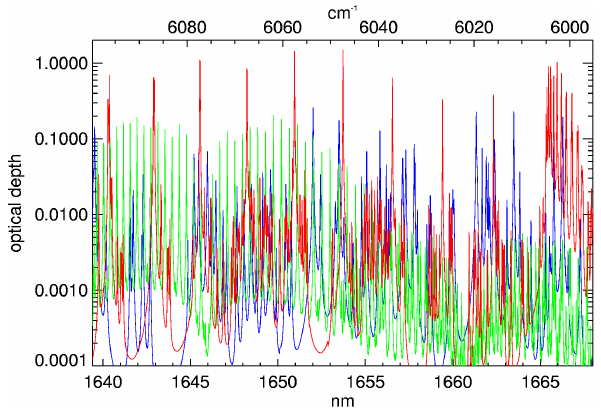
Fig. 3. Optical depth of the total vertical atmospheric column for option 2 of Table 1 under standard atmospheric conditions of water vapour (dotted), carbon dioxide (dashed) and methane (solid) ab- sorption lines. The thin solid line is the total optical depth of all three trace gases. The online (offline) wavelength position selected for the baseline system configuration is indicated by the thin vertical dashed (dotted)